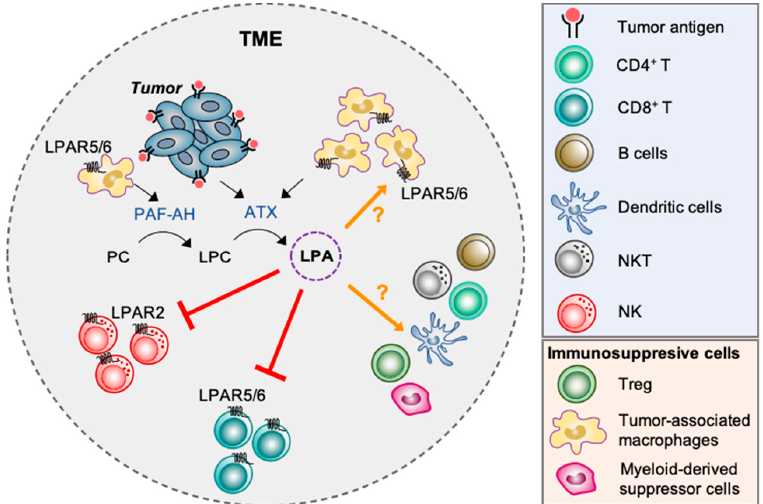
Figure 3. Potential role of ATX-LPA-LPAR signaling axis in the regulation of cancer immunity. Upregulation of LPA in the tumor microenvironment (TME) may serve as an inhibitory mechanism that suppress anti-tumor immunity via modulating the function of different immune cell types. For example, LPA may suppress the cytolytic actions of natural killer (NK) cells against tumor cells via LPAR2; block antigen-induced CD8 + T cell activation, proliferation and tumor-cell killing via LPAR5 receptor; and inhibit migration of CD8 + T cell into the tumor via LPAR6. Furthermore, the recruitment of TAM into the TME may serve as another source of LPA via the actions of PAF-AH and ATX. How LPA regulates TAM, CD4 + T cells, B cells, NKT cells, T reg and myeloid-derived suppressor cells in the TME remains to be determined.